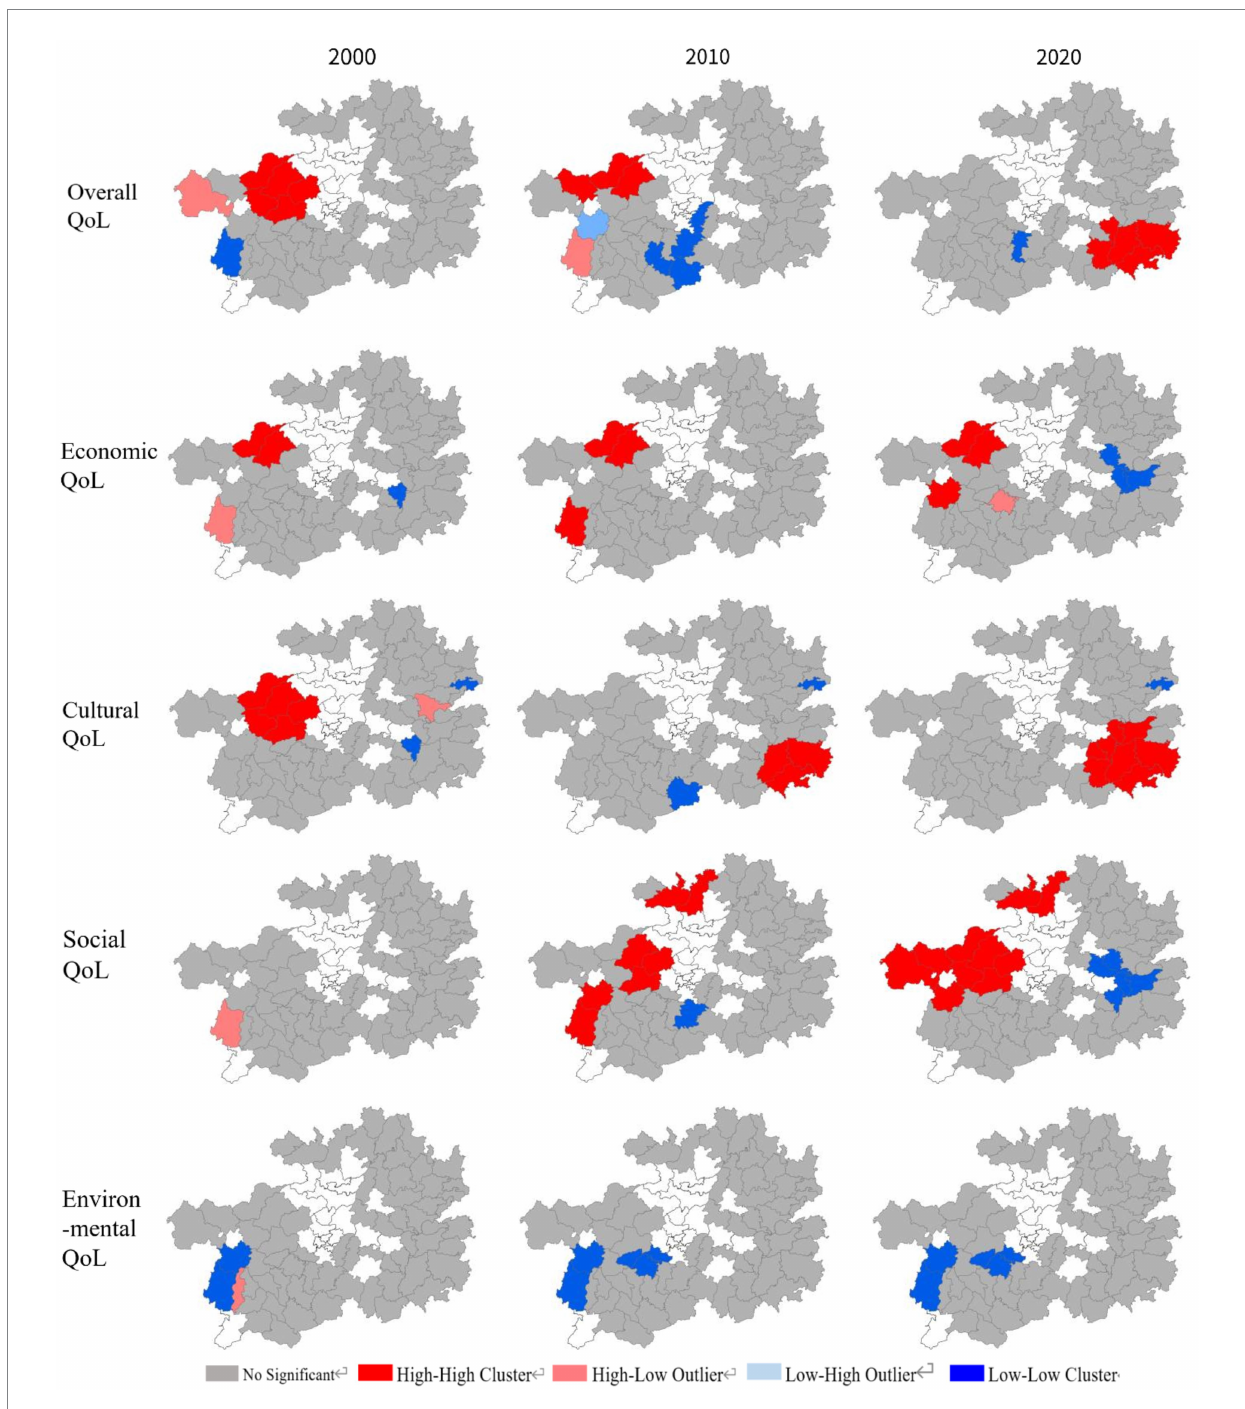
FIGURE 11 Analysis of the cold and hot spots in the QoL assessments of the impoverished districts and counties of Guizhou Province.